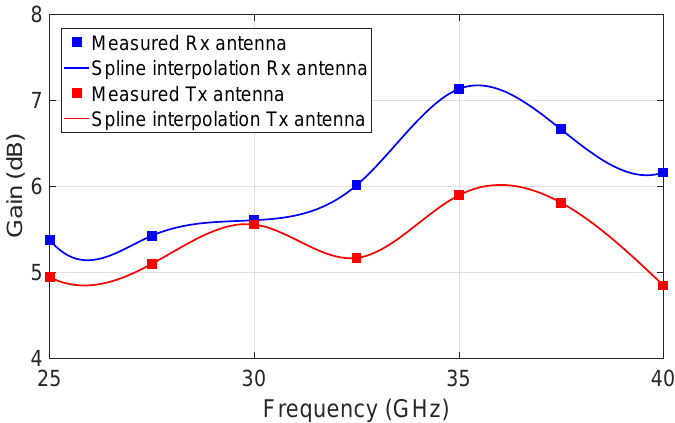
Figure 3. Measured antennas gain and cubic spline interpolation.